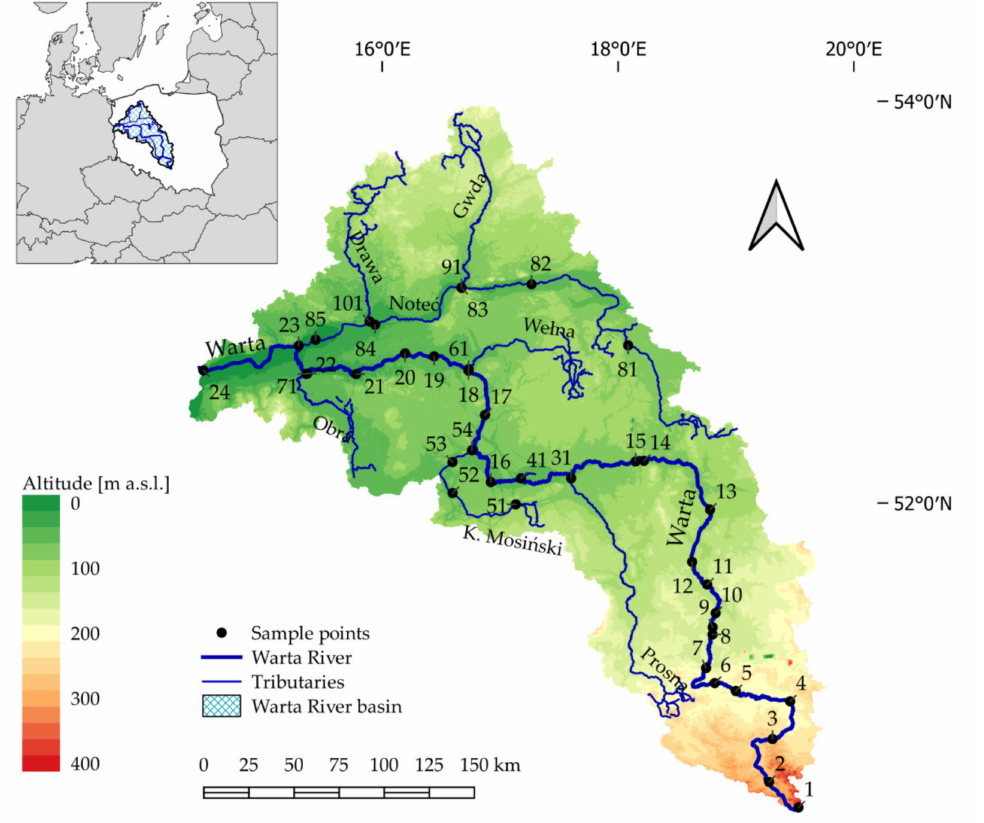
Figure 1. Study site